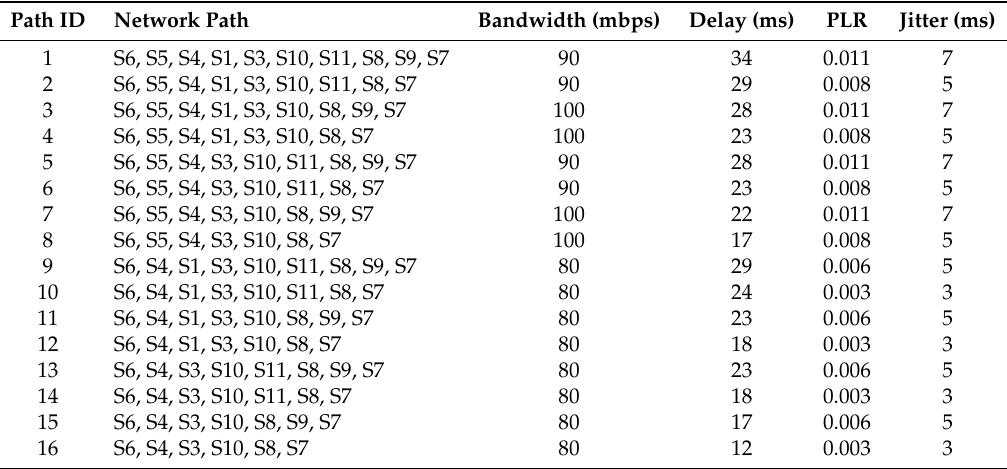
Table 5. Available network paths from Hosts 3 to 4 in the simulation